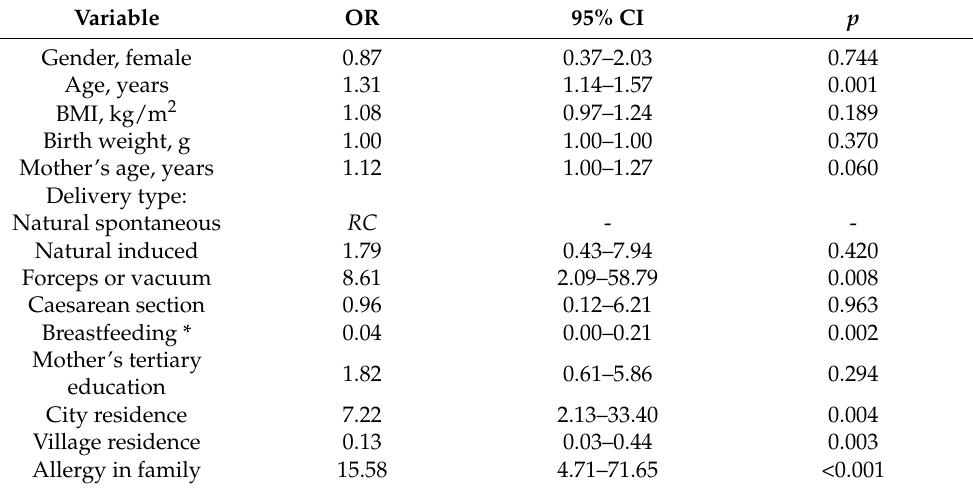
Table 2. Univariate logistic regression model results for asthma risk within the cohort of children included in the study (N =